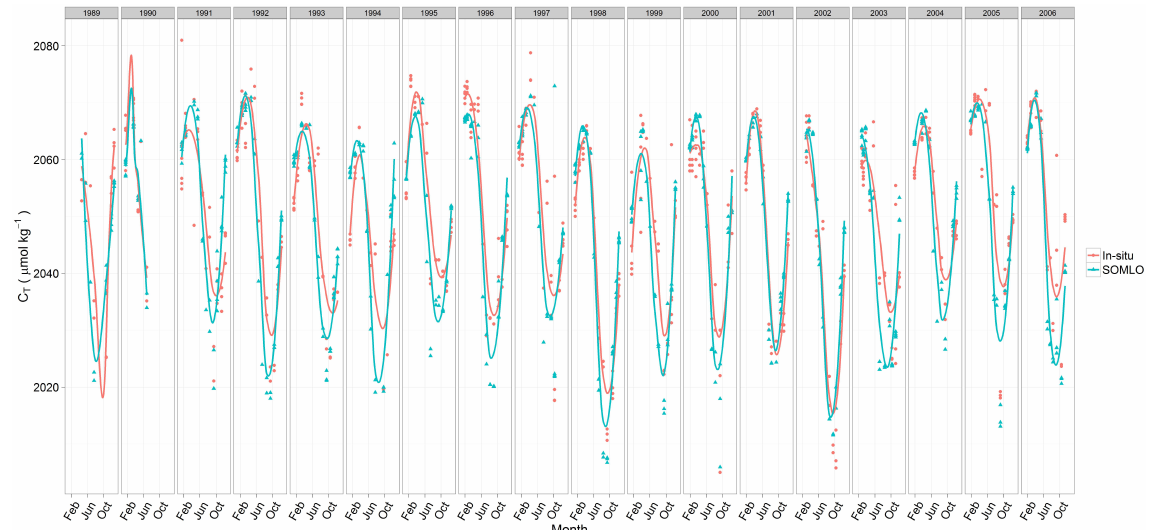
Fig. 17. In situ and independently predicted BATS C T measurements partitioned into years with loess fit (locally weighted scatter-plot smoothing).